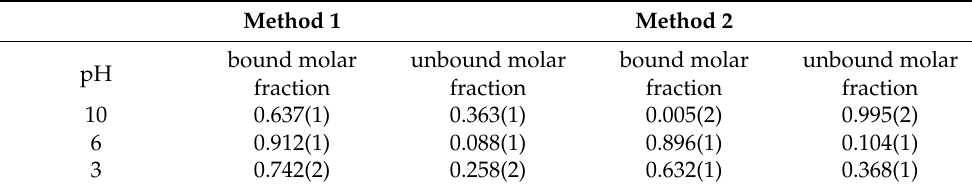
Table 4. Molar fraction of 99m Tc amount bound/unbound to NC depending on pH values. Mean (SD).